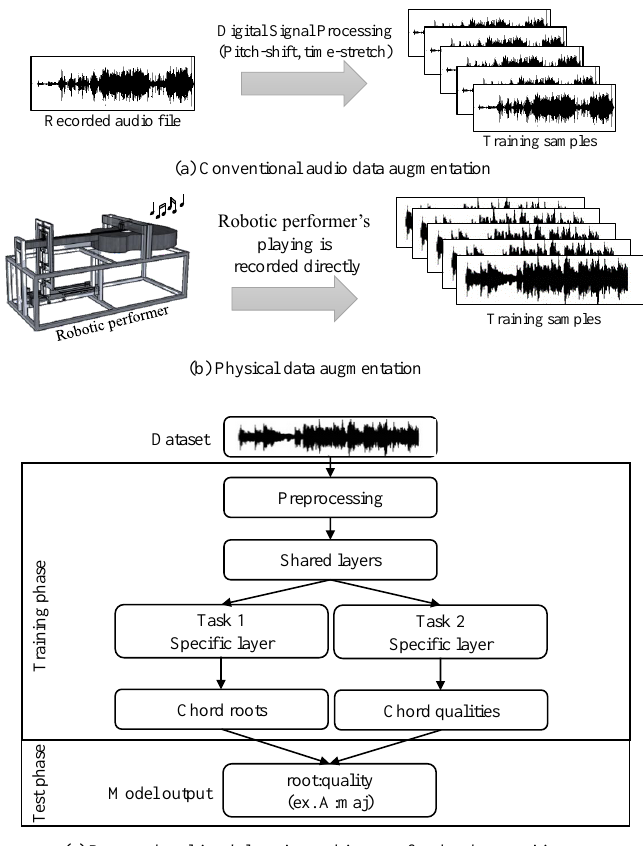
Figure 1. Proposed physical data augmentation method and multi-task learning method. ( a ) In the traditional method, digital signal processing techniques such as pitch-shifting or time-stretching are used to increase a small number of dataset samples. ( b ) In contrast, the proposed physical data augmentation method can generate high-quality training samples from the music performed by a controllable robot. ( c ) Dataset used to develop the proposed chord recognition model based on the multi-task learning (MTL) architecture. The proposed network architecture learns the chord root and qualities individually from the same audio file, and the model output is expressed using the ”root:quality” chord